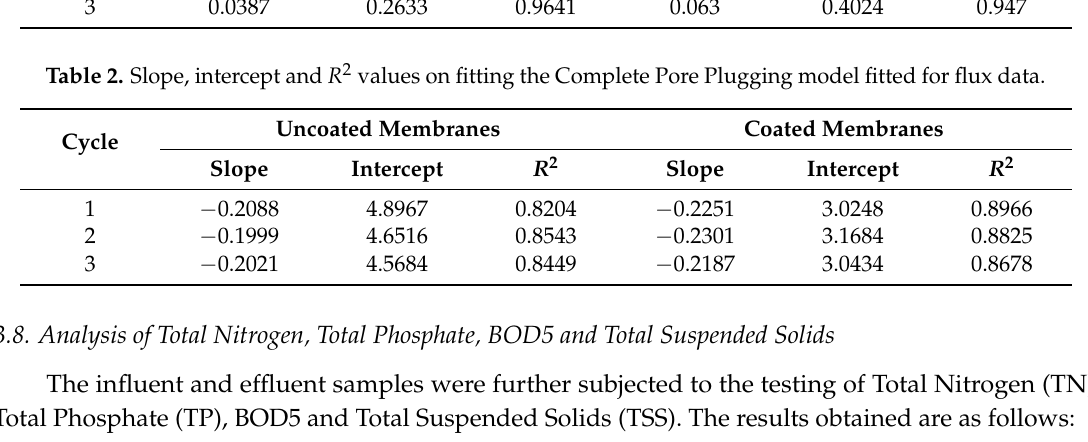
Table 1. Slope, intercept and R 2 values on fitting the Standard Pore Blocking model fitted for flux data. Uncoated Membranes Coated Membranes Cycle Slope Intercept R 2 Slope Intercept R 2 0.0369 0.2511 0.9574 0.0666 0.3935